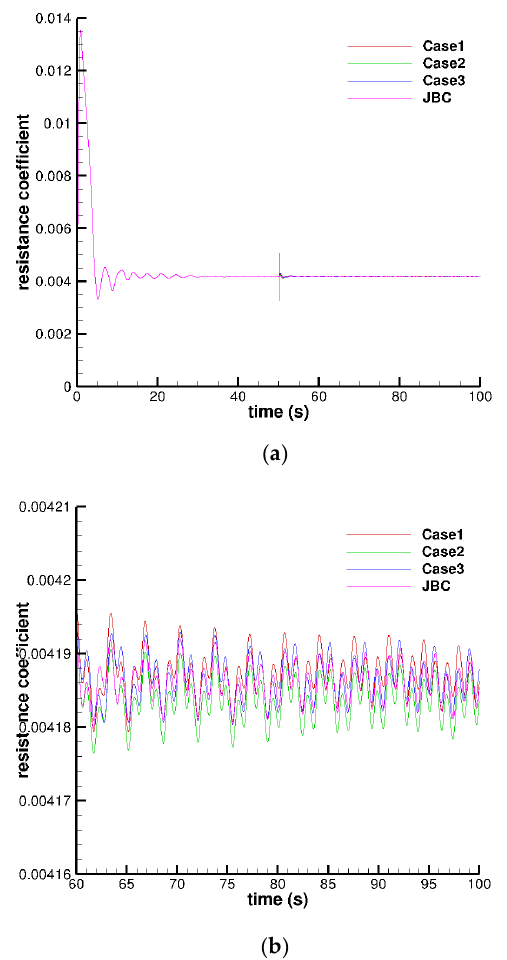
Figure 11. Comparisons of resistance convergence histories. ( a ) whole time, ( b ) zoomed. Table 4. Comparison of resistances of the JBC and deformed hull.